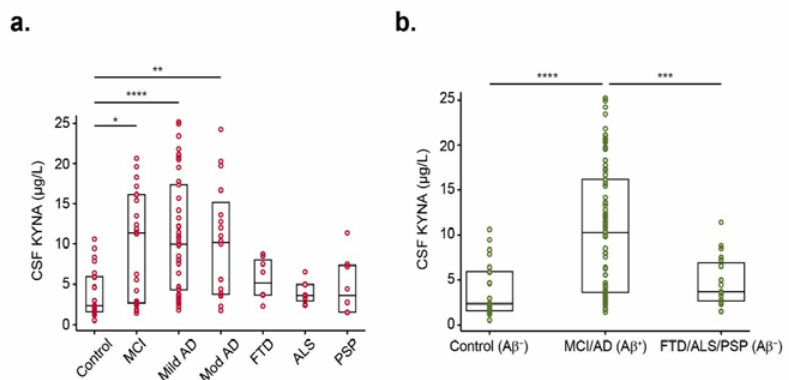
Figure 1. KYNA levels in CSF from all di ff erentially diagnosed groups of donors. ( a ) Scatter plots over box plots showing KYNA levels in CSF from all groups following the diagnosis. Boxes represent the 25th, 50th, and 75th data percentiles. KYNA levels were increased in MCI and AD dementia groups compared to controls. ( b ) Scatter plots displaying KYNA levels in CSF from subjects grouped throughout their CSF biomarker profile: controls ( n = 23), patients with AD-indicative CSF biomarker profiles ( n = 85), and patients without AD-indicative CSF biomarker profiles ( n = 24). Di ff erences between groups were assessed using Kruskal–Wallis test. * p < 0.05; ** p < 0.01; *** p < 0.001; **** p < 0.0001. MCI, mild